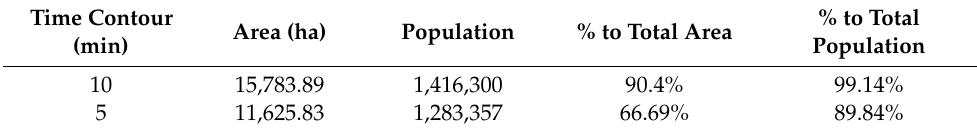
Table 4. Health facilities Service Coverage according to Time Contour.